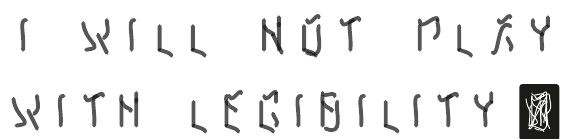
Figure 1: Stencil, and its glyphs, evolved with the presented framework in experiment